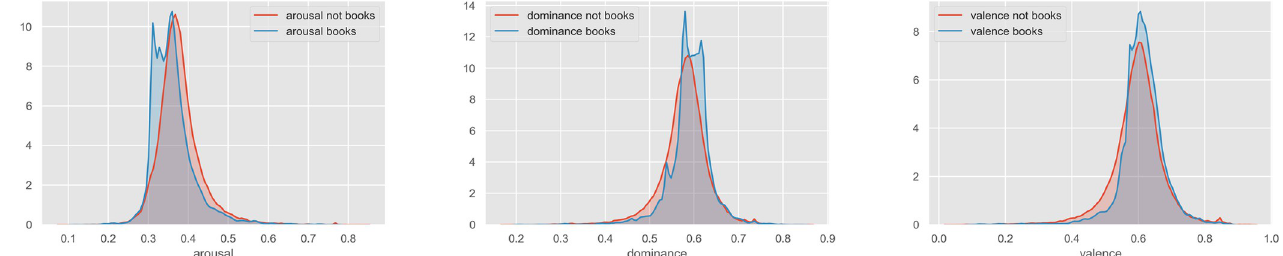
Fig 6. Two-sample Kolmogorov-Smirnov tests for differences in distribution shape significant at the p < .001 level (test statistics: 0.2, 0.17, 0.14).